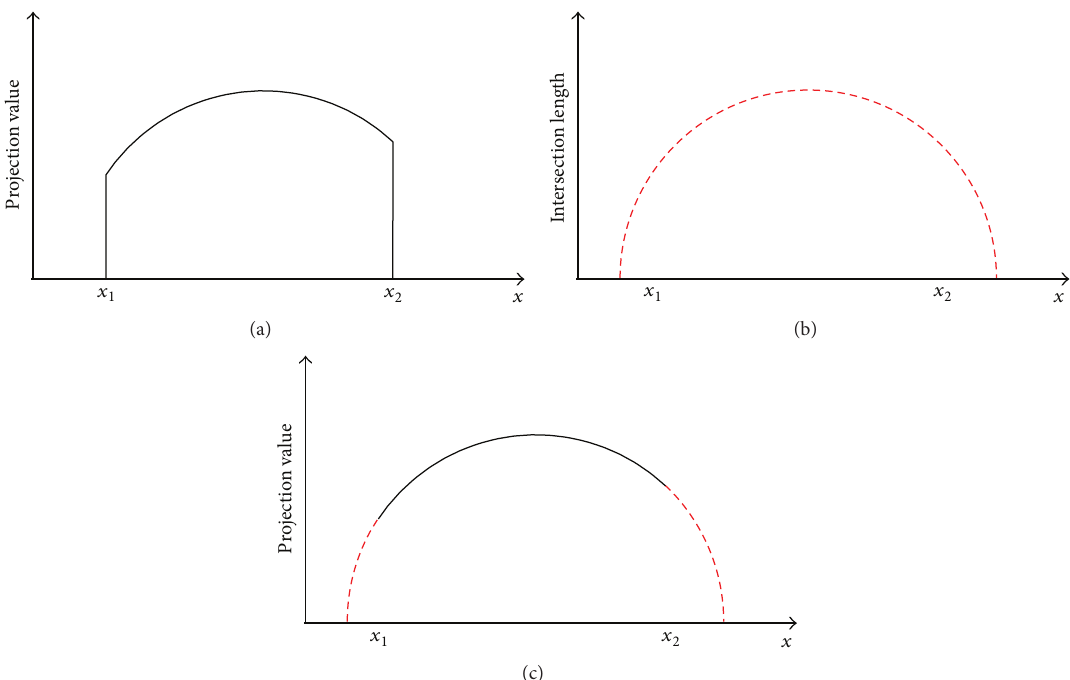
Figure 9: (a) shows exemplary values for an overexposed projection. Due to the saturation, there is no reliable information beyond the transition points to the overexposed regions 𝑥 1 and 𝑥 2 . For correction, the calculated intersection lengths (b) are normalized to the projection value at 𝑥 1 and 𝑥 2 and used to extrapolate the boundary of the saturated object (c).